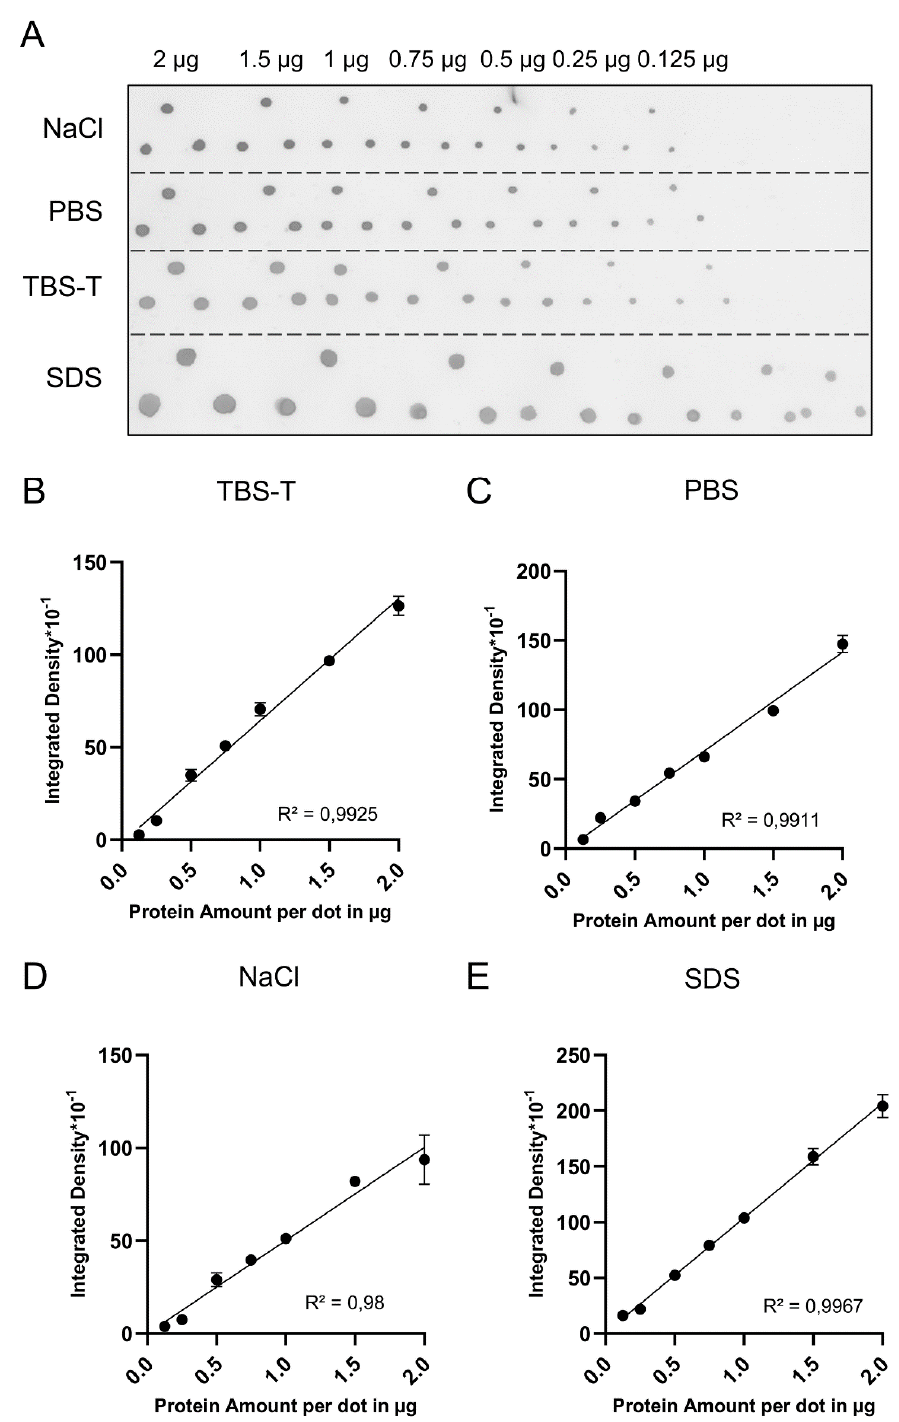
Figure 2. Comparison of diluents for the PDB assay. ( A ) Ponceau S-stained dot blot. BSA was diluted in different solutions to a final concentration of 1 µ g/ µ L. Variable volumes of the solutions containing indicated BSA amounts were spotted in triplicate onto a nitrocellulose membrane. ( B – E ) Inverted standard curves based on Figure 2A. Error bars indicate SEM. R 2 = Coefficient of determina- tion. As indicated by higher R 2 values and lower error deviations between technical repli- cates, TBS-T and 0.1% SDS in water outperformed PBS and 0.5 M NaCl (Figure 2B–E).